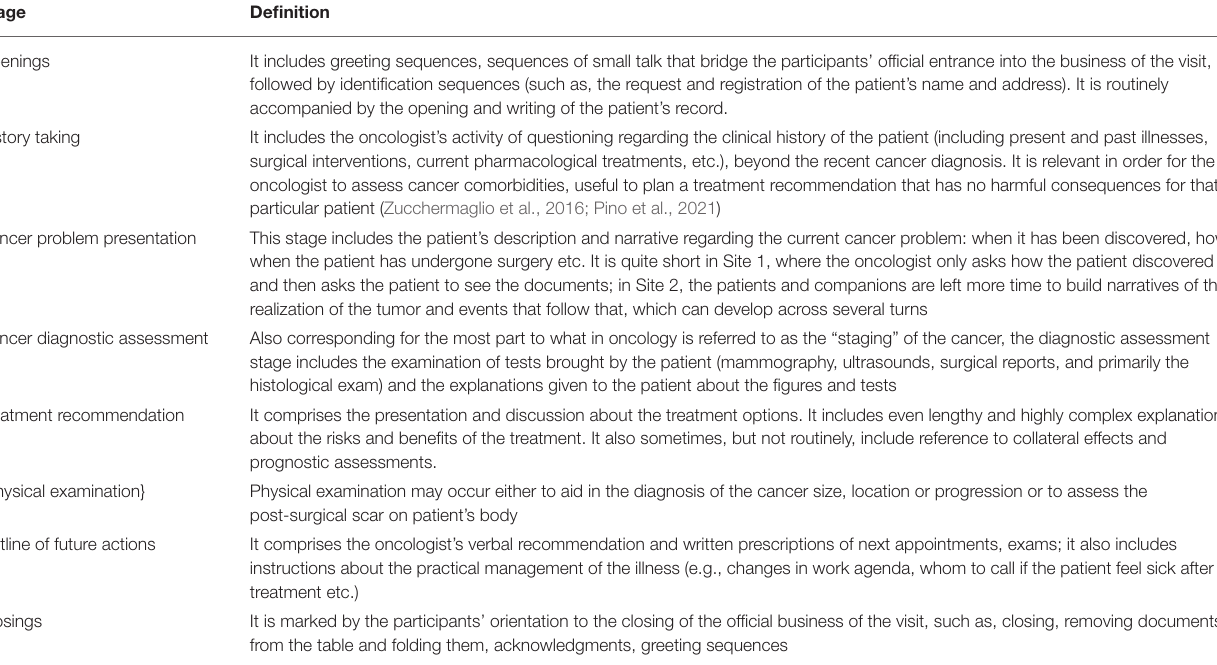
TABLE 2 | Stages of the oncological visit (Fatigante et al.,